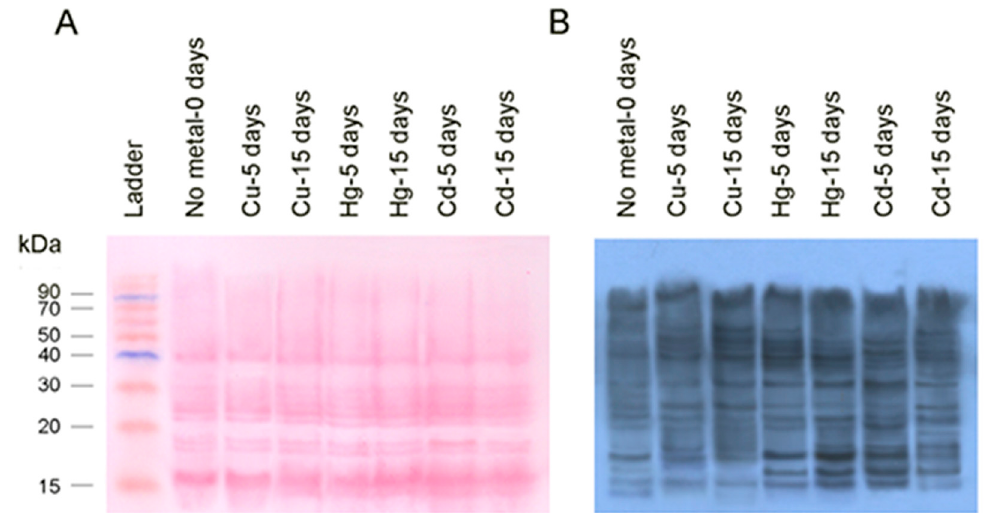
Figure 4. Electrophoretic run of ribosomal proteins and immunoblotting using anti-DNPH as primary antibody: ( A ) Ponceau S staining; ( B ) profile of carbonylated proteins in the fraction of ribosomal proteins isolated from non-exposed (no metal, 0 days) or exposed mussels to 40 µ g / L Cu, 30 µ g / L Hg, or 100 µ g / L Cd for 5 or 15